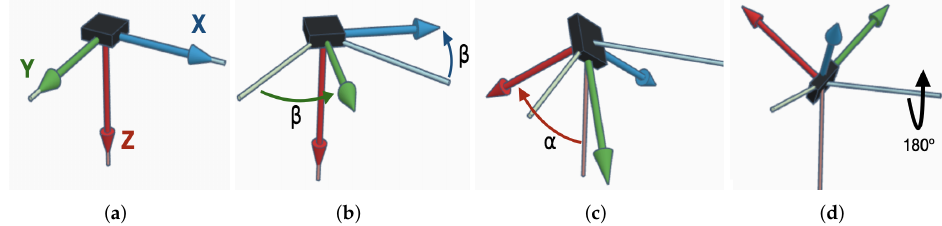
Figure 2. Rotation sequence used during the calibration tests. ( a ) Reference Orientation. ( b ) First Rotation. ( c ) Positive Forces Orientation. ( d ) Negative Forces